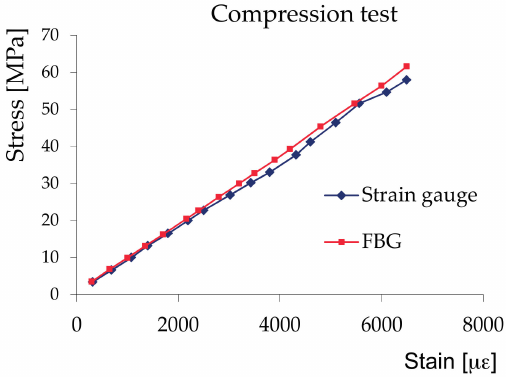
Figure 6. Compression test: stress–strain